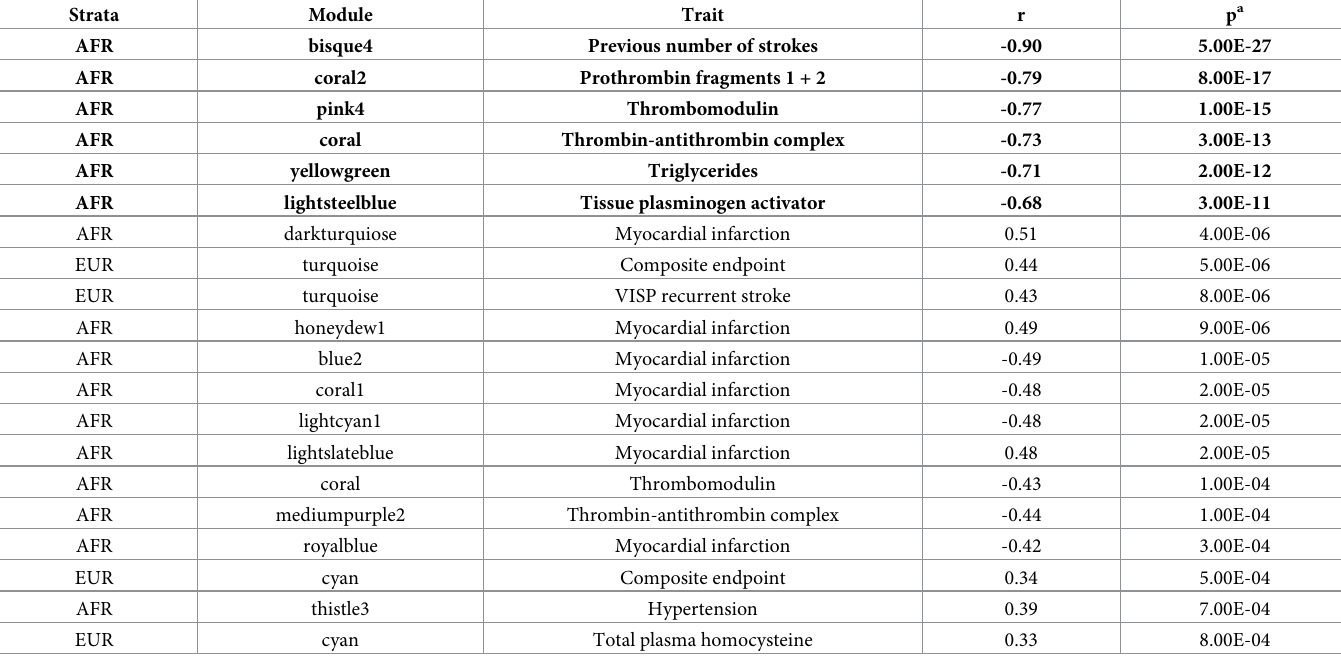
ciated with shorter duration to recurrent stroke or composite vascular event, thus suggesting Table 5. Significant WGCNA module-trait